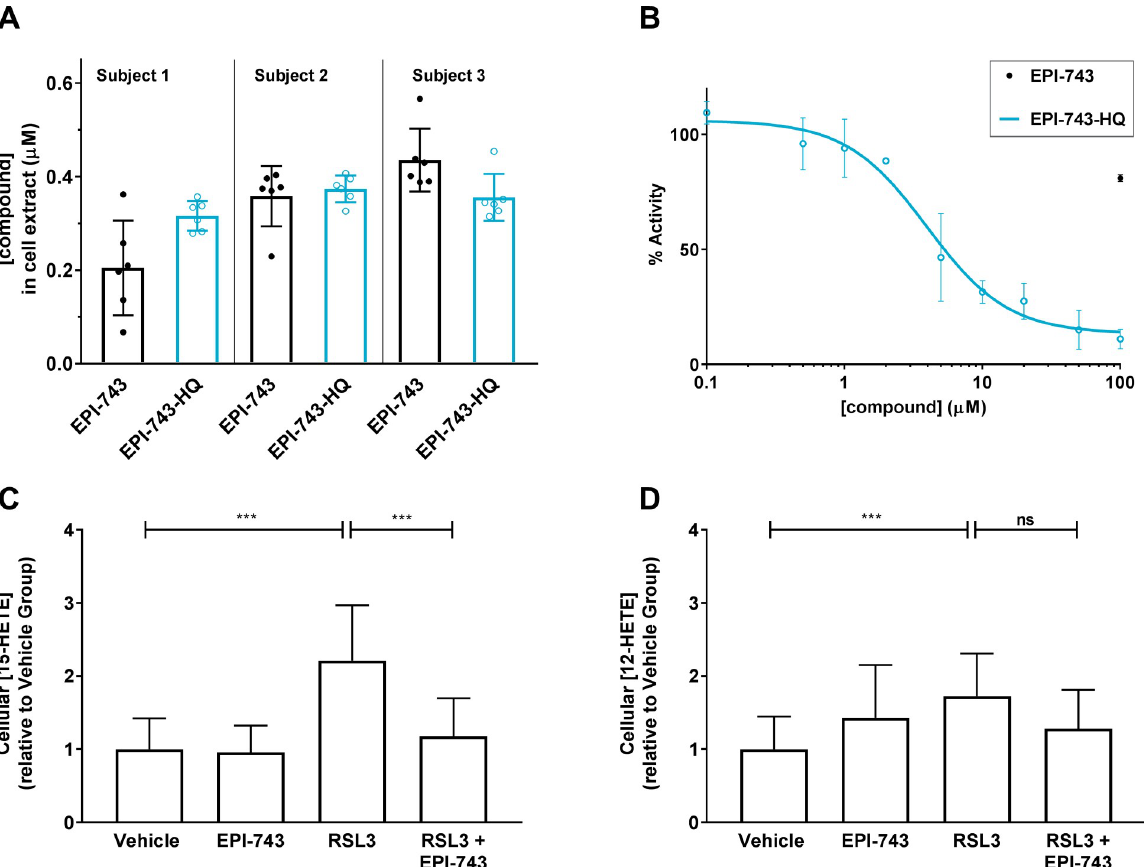
Fig 3. EPI-743 hydroquinone is detected in PCH6 patient fibroblasts and inhibits human 15-LO. (A) Dosed EPI-743 (1 μ M, 3 h) was reduced to EPI-743 hydroquinone (EPI-743-HQ) in PCH6 patient fibroblasts from Subjects 1, 2, and 3. Mean ± SD displayed, N = 6 per subject. (B) The activity of purified human 15-LO was monitored via a ferrous oxidation-xylenol orange (FOX) method. EPI-743-HQ dose-dependently inhibited human 15-LO enzyme activity, whereas EPI-743 showed only 20% inhibition at 100 μ M. Mean ± SD displayed, N = 2. The IC 50 for the displayed curve is 4.4 μ M. (C, D) LC-MS/MS measurement of downstream products of 15-LO (15-HETE, C) and 12-LO (12-HETE, D) in PCH6 patient (Subject 1) fibroblasts following RSL3 (2 μ M, 4 h) challenge, without or with EPI-743 (200 nM) co-treatment. Compound was dosed in the quinone form. Results shown are N = 17 replicates from three independent experiments. Mean ± SD displayed. ��� , p < 0.001; ns, not significant; by Kruskal-Wallis test followed by Dunn’s multiple comparisons test. We noted that cellular 15-hydroperoxyeicosatetraenoic acid (15-HpETE), the direct product of 15-LO acting upon arachidonic acid as substrate, was not consistently detected within the quantifiable range by LC-MS/MS in our studies.